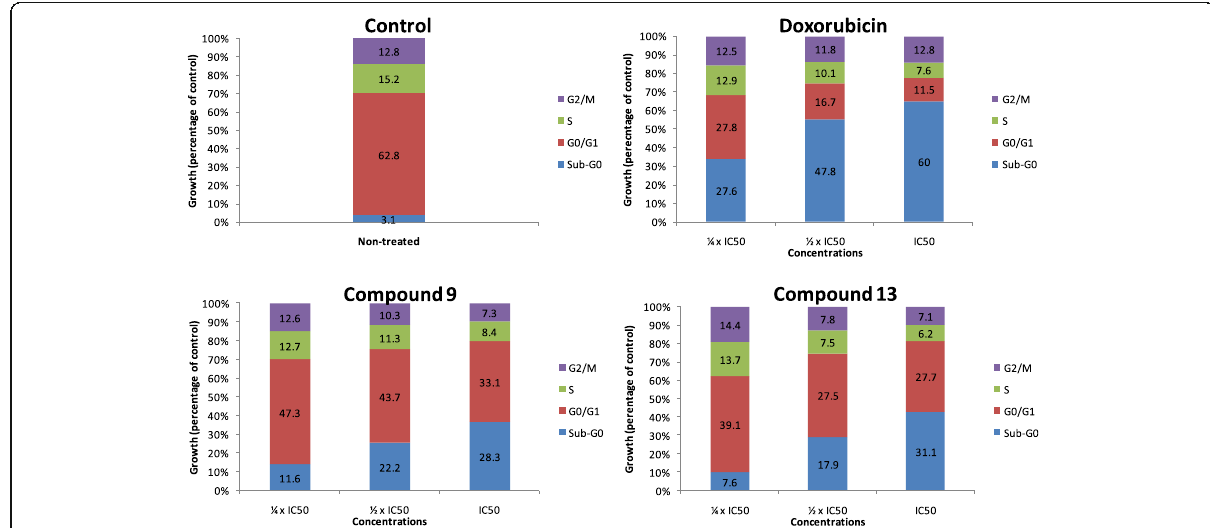
Fig. 2 Cell cycle distribution of MCF-7 cells treated with thonningiol (9), seputhecarpan D (13) and doxorubicin for 72 h. IC 50 : 0.36 μ M (thonningiol), 9.78 μ M (seputhecarpan D) and 0.35 μ M